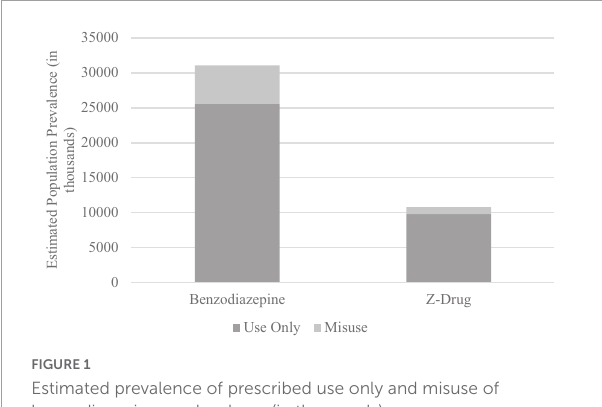
FIGURE1 Estimated prevalence of prescribed use only and misuse of benzodiazepines and z-drugs (in